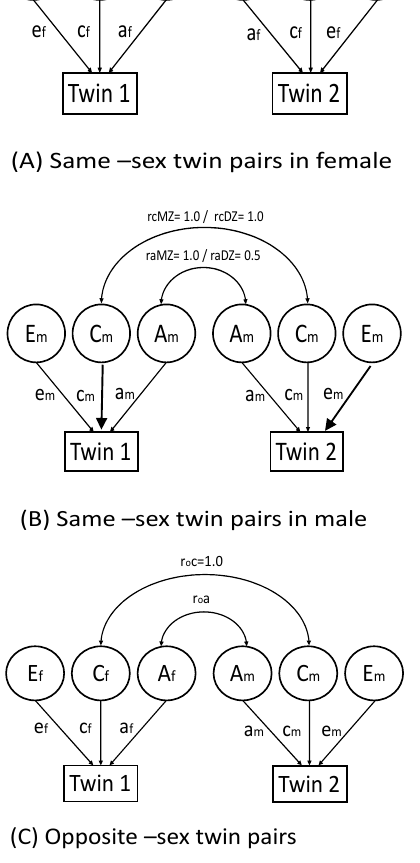
Figure 1. ( A ) Same-sex twin pairs in females, ( B ) same-sex twin pairs in males, ( C ) opposite-sex twin pairs. Abbreviations: MZ, monozygotic; DZ, dizygotic; Af, additive genetic factors for female sex; Cf, shared environmental factors for female sex; Ef, nonshared environmental factors for female sex; Am, additive genetic factors for male sex; Cm, shared environmental factors for male sex; Em, nonshared environmental factors for male sex; af, cf, and ef were path coefficients for females; am, cm, and em were path coefficients for males; af, cf, and ef were path coefficients for female sex; am, cm, and em were path coefficients for male sex; raMZ, additive genetic correlation between monozygotic twins; raDZ, additive genetic correlation between same-sex dizygotic twins; roc = shared environmental correlation between opposite-sex twins; roa = additive genetic correlation between opposite-sex twins. Rectangles represent observed variables, and circles represent latent variables. Full sex-limitation models estimated all parameters separately in males and females. Common effect models estimated parameters separately in males and females, fixing roa = 0.5. Scalar models estimated parameters, fixing roa = 0.5, af = am, cf = cm, and ef = em. Null models estimated parameters, fixing roa = 0.5, af = am, cf = cm, ef = em, phenotypic variance of females = phenotypic variance of